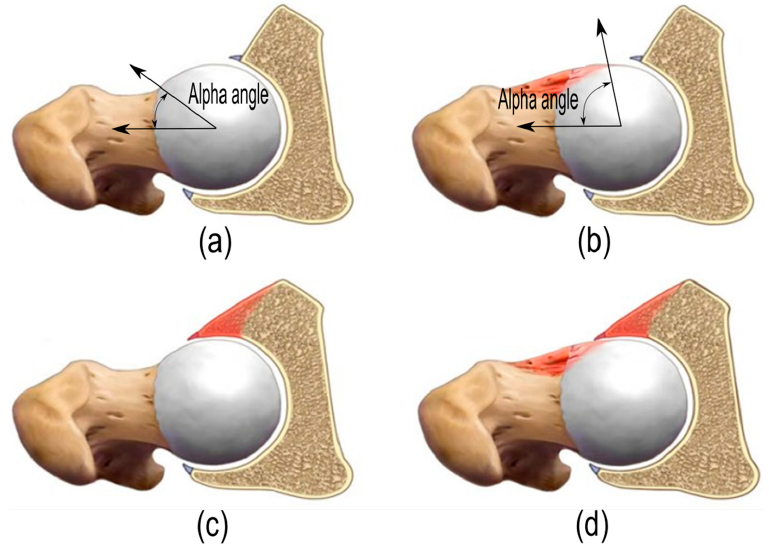
Figure 1. Types of hip joint with femoroacetabular impingement: ( a ) healthy hip joint, ( b ) Cam-type, ( c ) Pincer-type and ( d ) mixed-type [7,25].